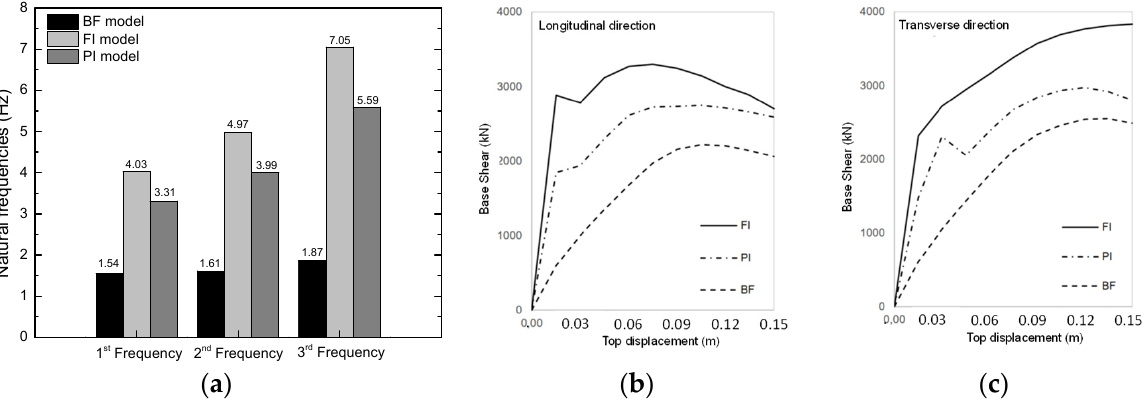
Figure 7. Numerical results. ( a ) Natural frequencies. Capacity curve (pushover analysis): ( b ) longitudinal direction; and ( c ) transverse direction.